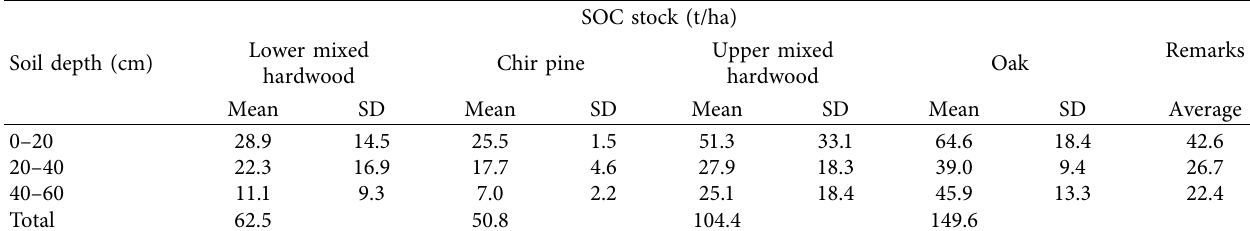
Table 3: Total SOC stock of different forest types at different soil depths.